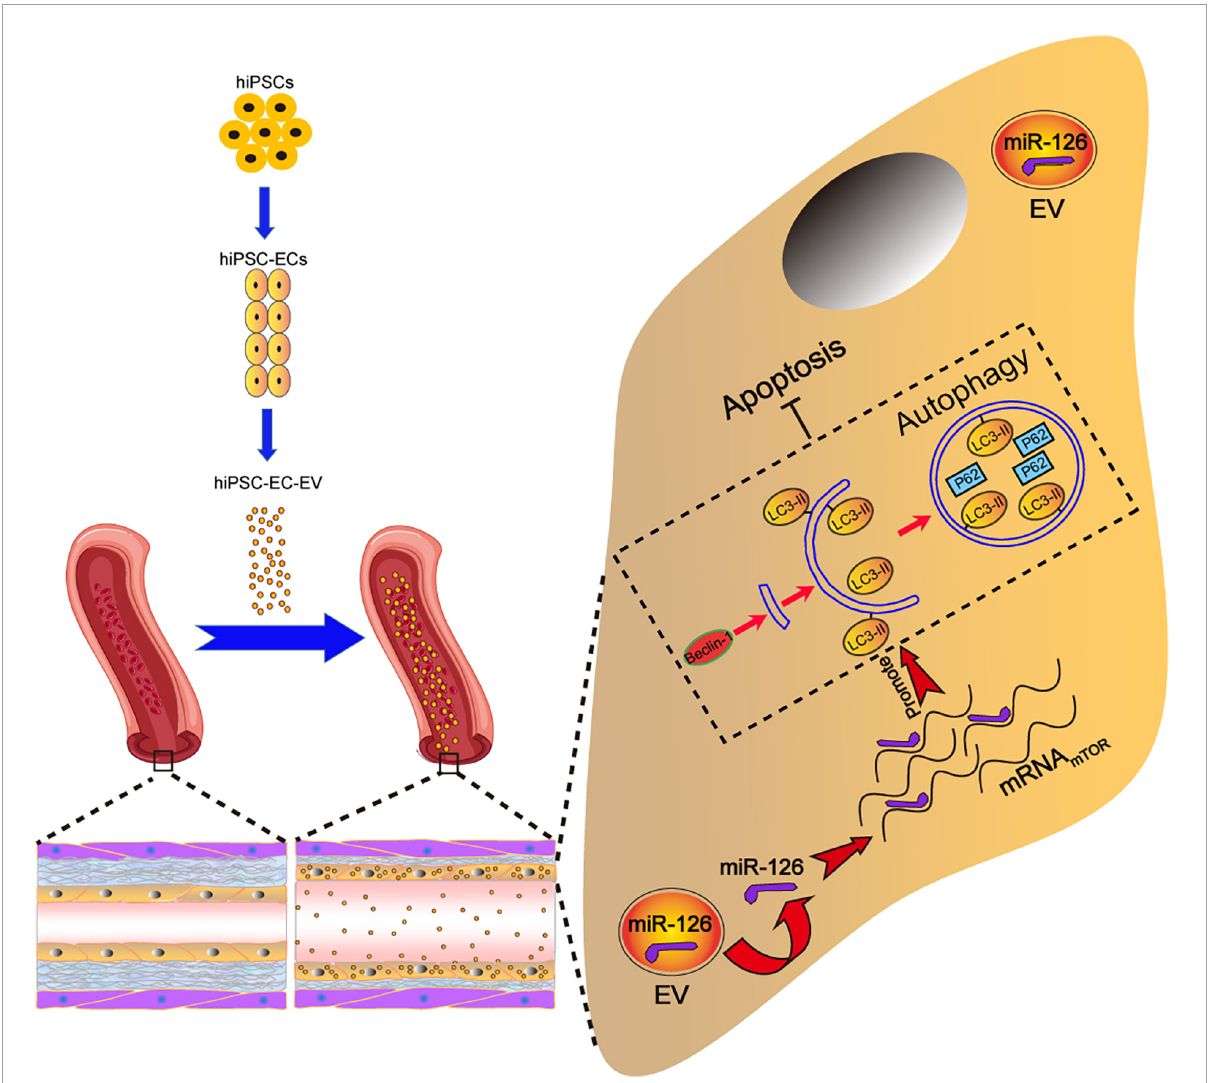
FIGURE8 Schematic illustration of the tentative mechanism for alleviation of arterial restenosis by hiPSC-EC-EV treatment in mice via the miR-126-mediated autophagy regulation. Intravenously (iv)-injected hiPSC-EC-EV enriched in miR-126 could accumulate on the surface of the carotid artery endothelium, and suppress apoptosis in the ECs via autophagy